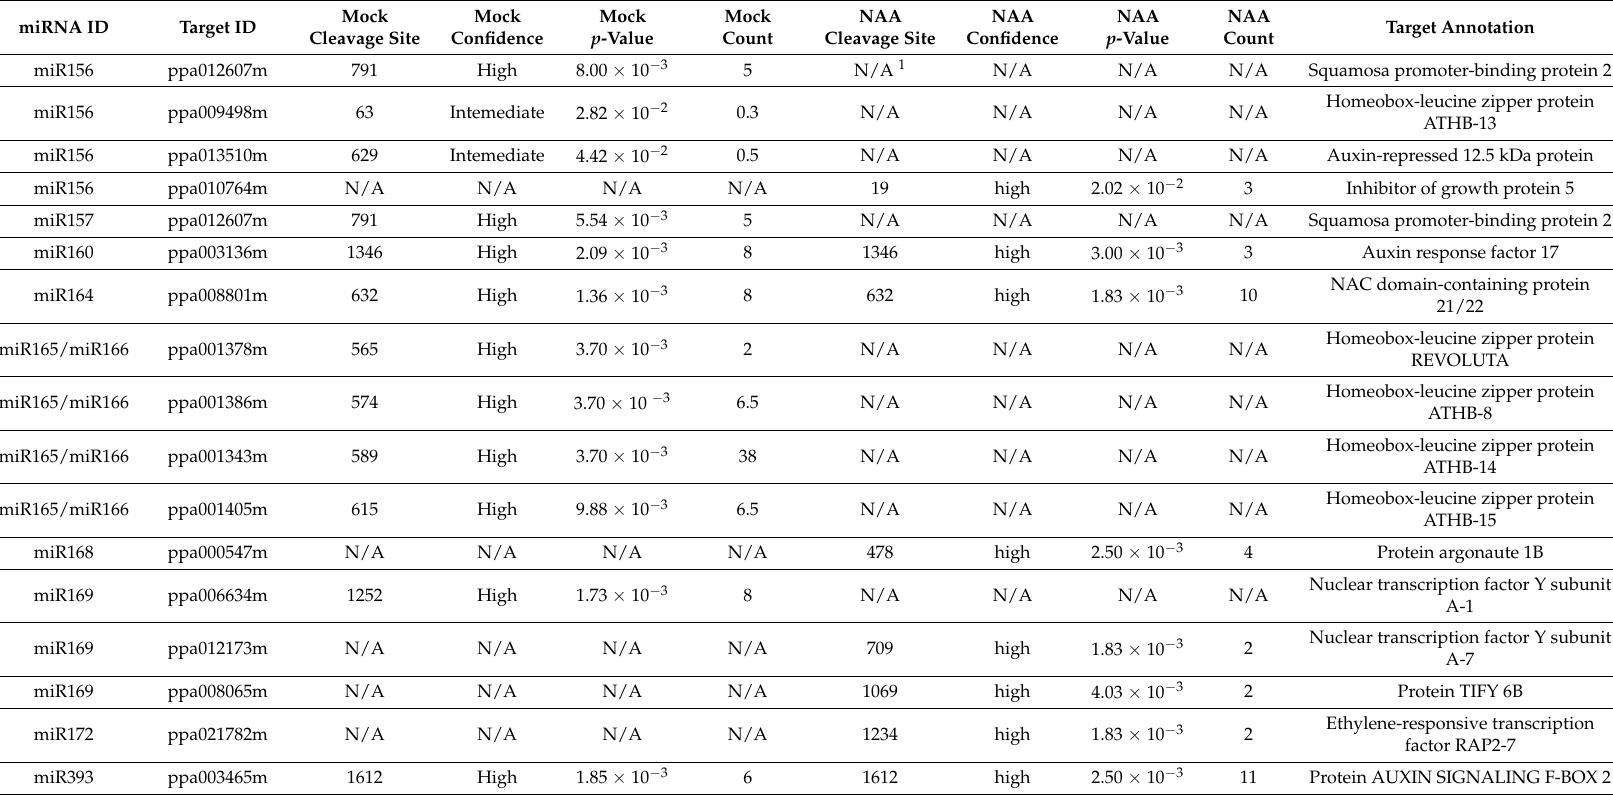
Table 1. List of conserved miRNAs obtained from control and α -naphthylacetic acid (NAA)-treated mesocarp of